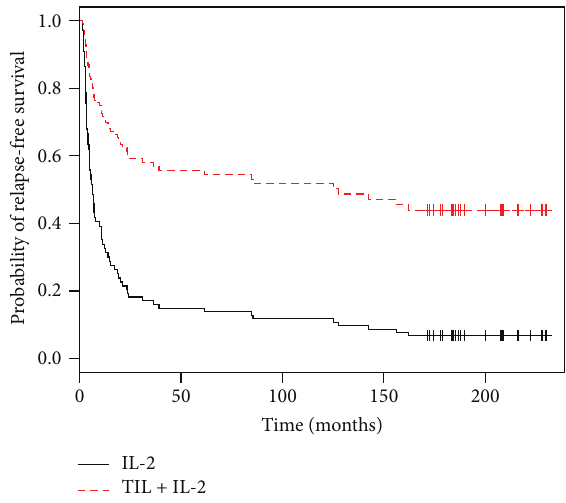
Figure 2: Cox model curves when the Breslow is > 1.5, a capsular breaking is present, and only one lymph node is